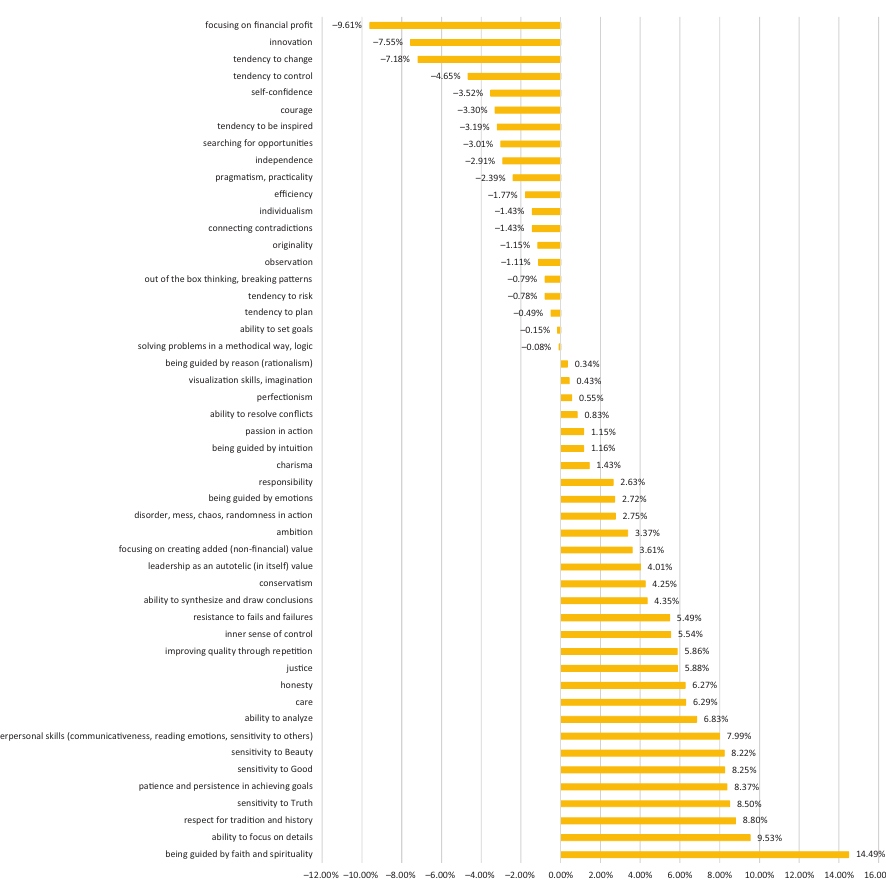
Figure 5. Perception of the 50 features of a creator’s identity by artistic versus non-artistic individuals (source: created by